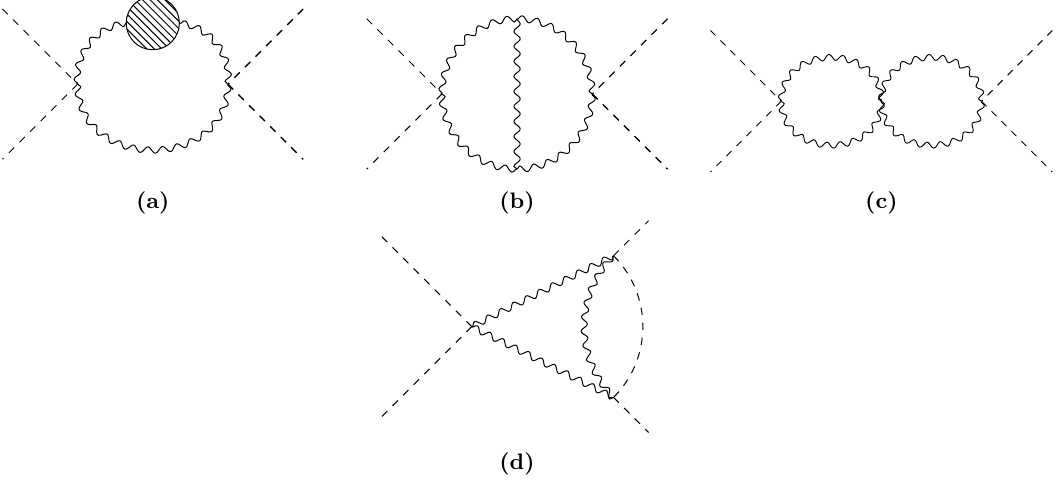
Figure 16. ( gauge 6 ) contributions to the two-loop beta function of quartic